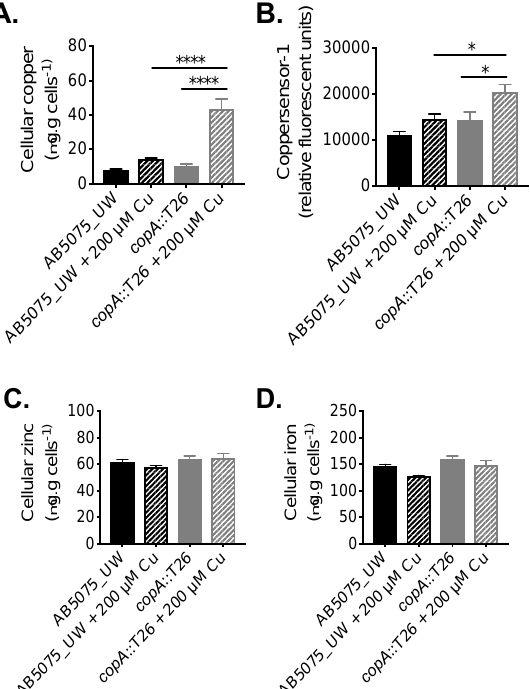
Figure 3. The role of CopA in A. baumannii metal ion homeostasis. ( A ) To examine the total cellular copper levels, mid-log phase cells, with or without 200 µM CuSO 4 , were analysed by ICP-MS, with the data represented as the weight of metal (µg) per dry weight of cell material (g). ( B ) Cellular copper was also examined by measuring coppersensor-1 fluorescence by flow cytometry (fluorescent units corrected to unlabelled cells) in cells grown with or without 200 µM CuSO 4 . To examine the total cellular ( C ) zinc and ( D ) iron levels, mid-log phase cells, with or without 200 µM CuSO 4 , were analysed by ICP-MS, with the data represented as the weight of metal (µg) per dry weight of cell material (g). The data in all analyses represent the mean (±SEM) of at least biological triplicates. Statistical analyses were performed with a one-way ANOVA (* p < 0.05; **** p < 0.0001). Int. J. Mol. Sci. 2018 , 19 , x